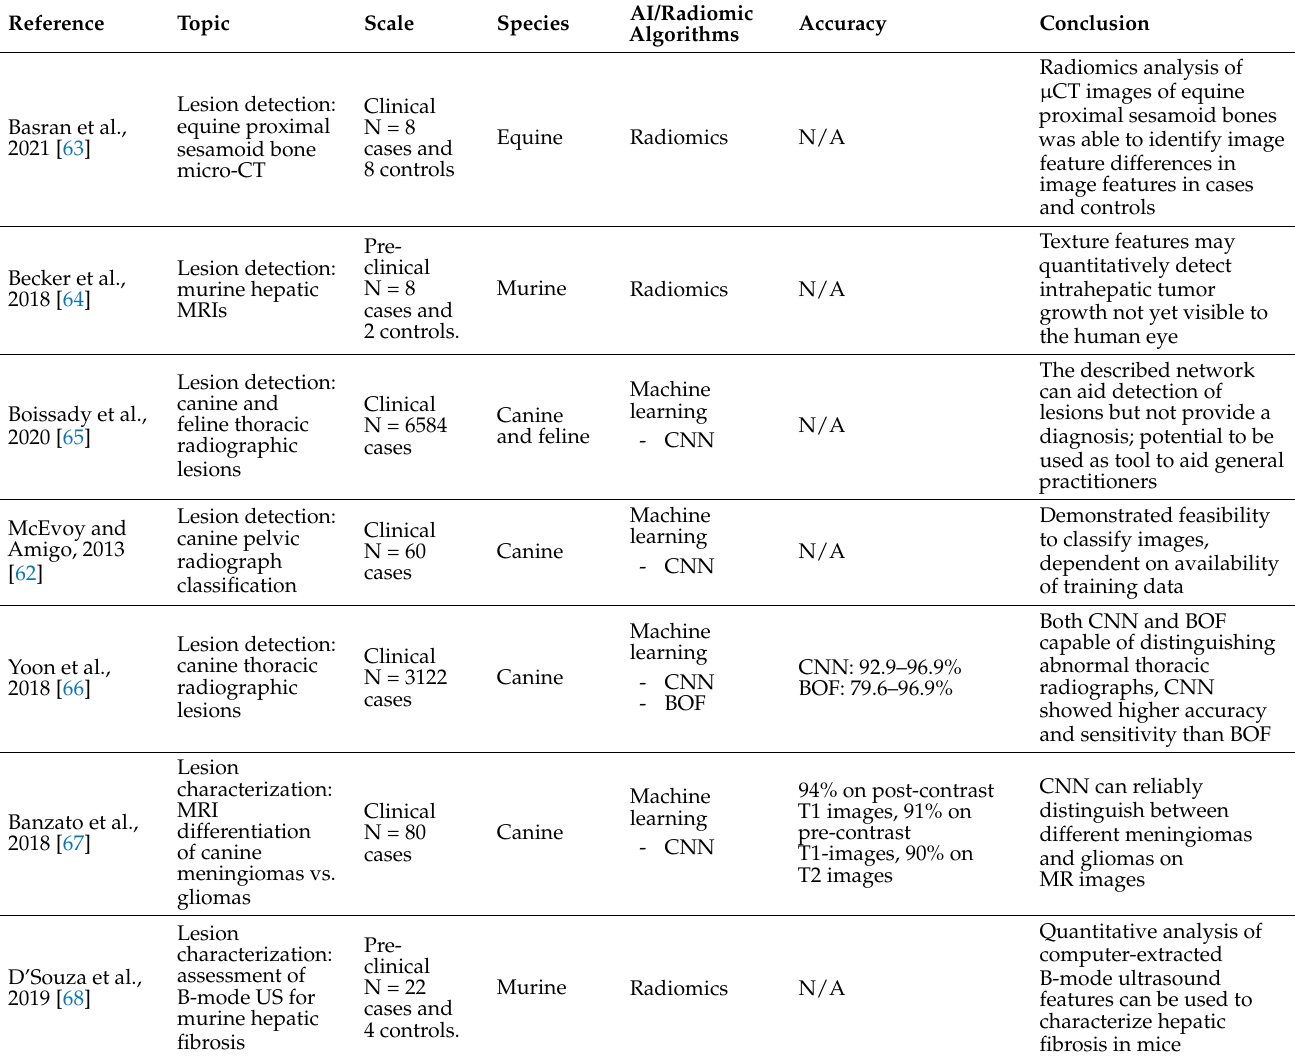
Table 3. Literature review of AI/radiomics studies in the veterinary imaging applications, with reported accuracies and conclusions. CNN: convolutional neural networks. N/A: not